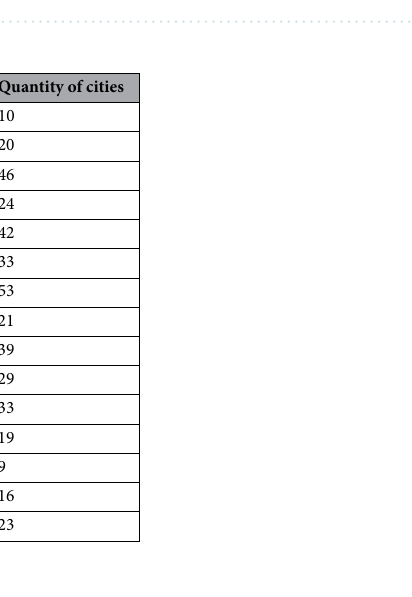
Figure 4. Daily records of dengue cases are available by Brazilian Diseases Notification System databases (SINAN) 25 . The economic arrangement proposed by the Superintendence of Economic and Social Studies State of Bahia-Brazil (SEI-BA) 24 . Among several arrangements, the SEI-BA provides the Economic Regions (ER) which is supported by Bahia’s low # 6.349 24 . The ρ DCCA cross correlation analysis method 26 was applied at SINAN filtered data aggregated by ER.